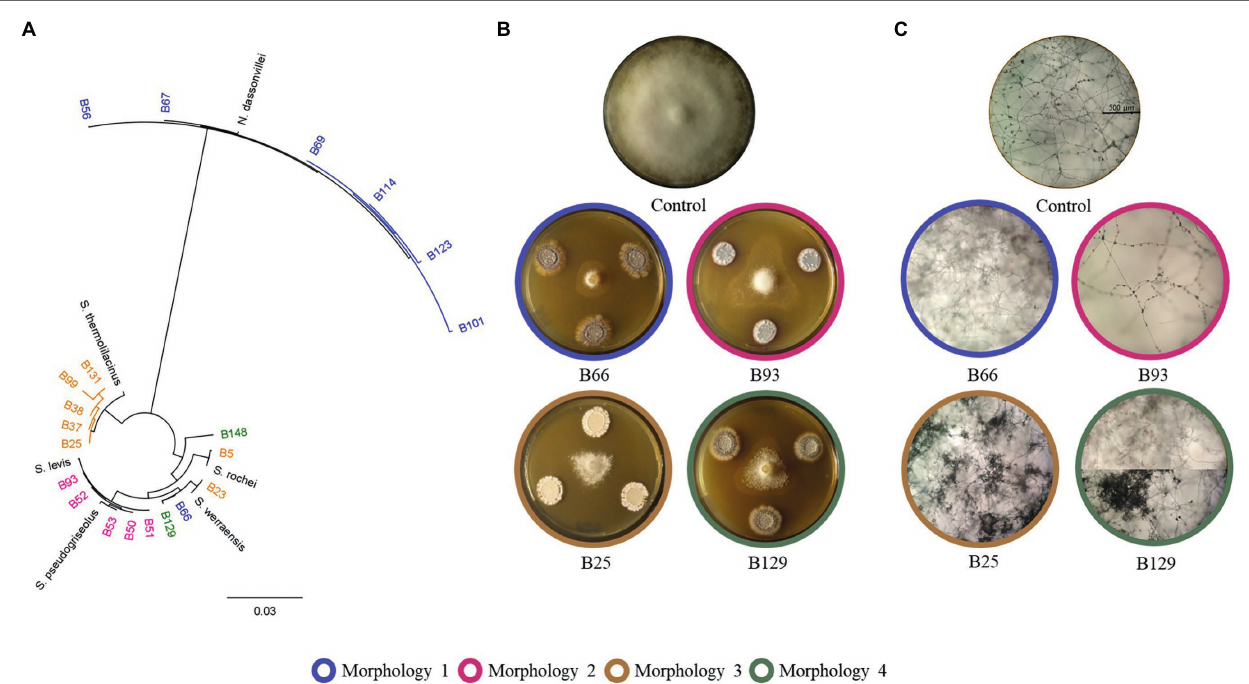
FIGURE 3 | Different morphologies of Phytophthora infestans caused by Actinomycetes. (A) Phylogenetic tree showing the clusters of the strains, which caused the four described morphologies. (B) Representative plates showing the four different morphologies. (C) Microscopic pictures showing the altered mycelium and sporangia morphologies caused by the Actinomycetes